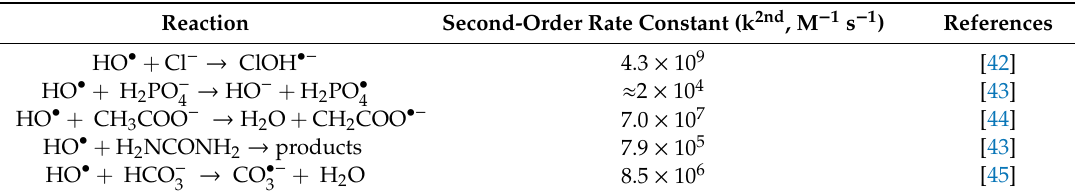
Figure 5. Scheme of degradation routes and interfering action of the urine components on the tested processes and generation of primary degradation products. ( a ) UVC / H 2 O 2 ; ( b ) sonochemical treatment. Note: black arrows mean degradation routes and red arrows represent interfering action of the urine components. Table 4. Rate constants of the reactions between hydroxyl radical and the diverse components of fresh